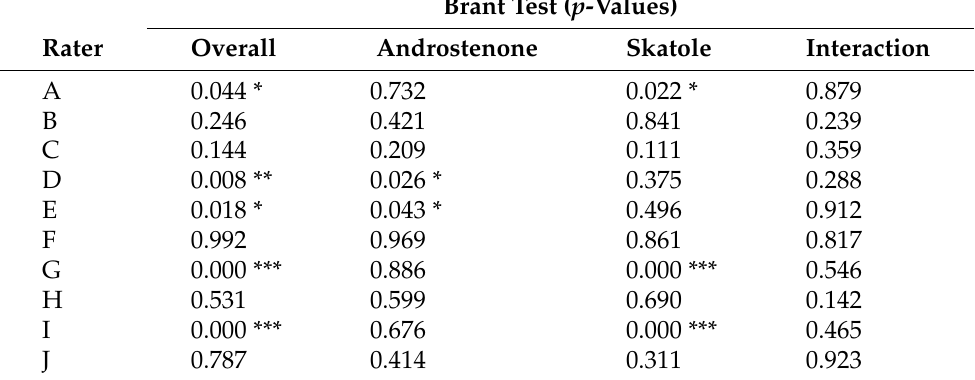
Table 1. The p -values of the Brant test of proportional odds across categories of the individual panelist ratings of deviant smell in boar samples; with usual significance codes: ‘***’ 0.001 ‘**’ 0.01 ‘*’